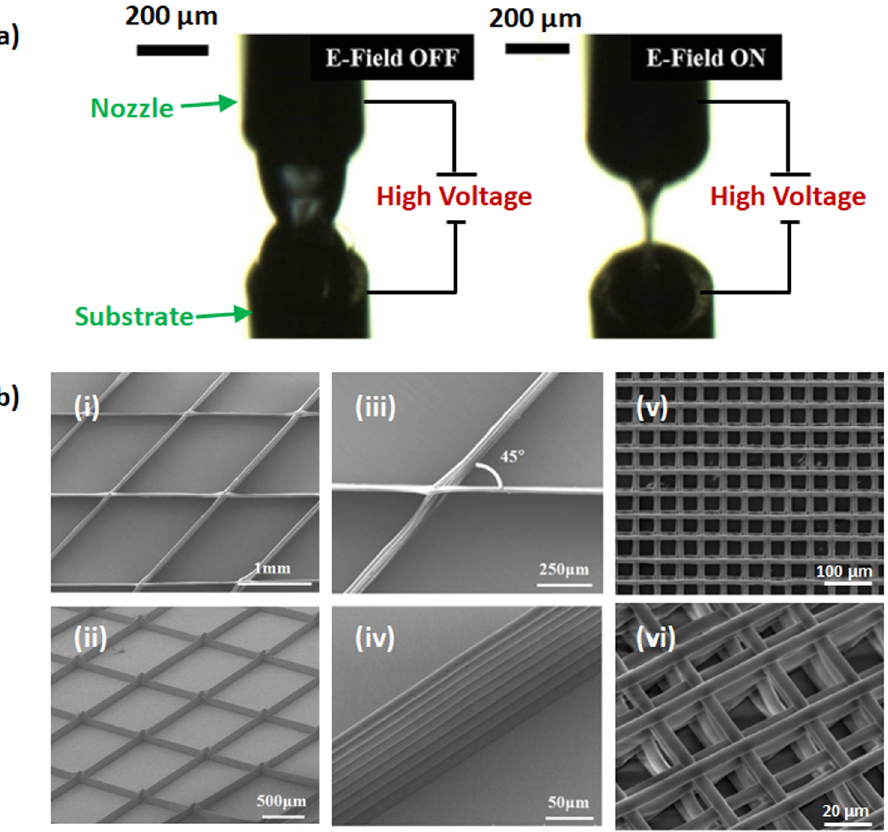
Figure 8: ( a ) Electric fi eld OFF/ON e ff ect on E - FDM printing; ( b ) E - FDM - printed 3D sca ff old structures. Adopted from ref. [ 90 – 92 ] with modi fi